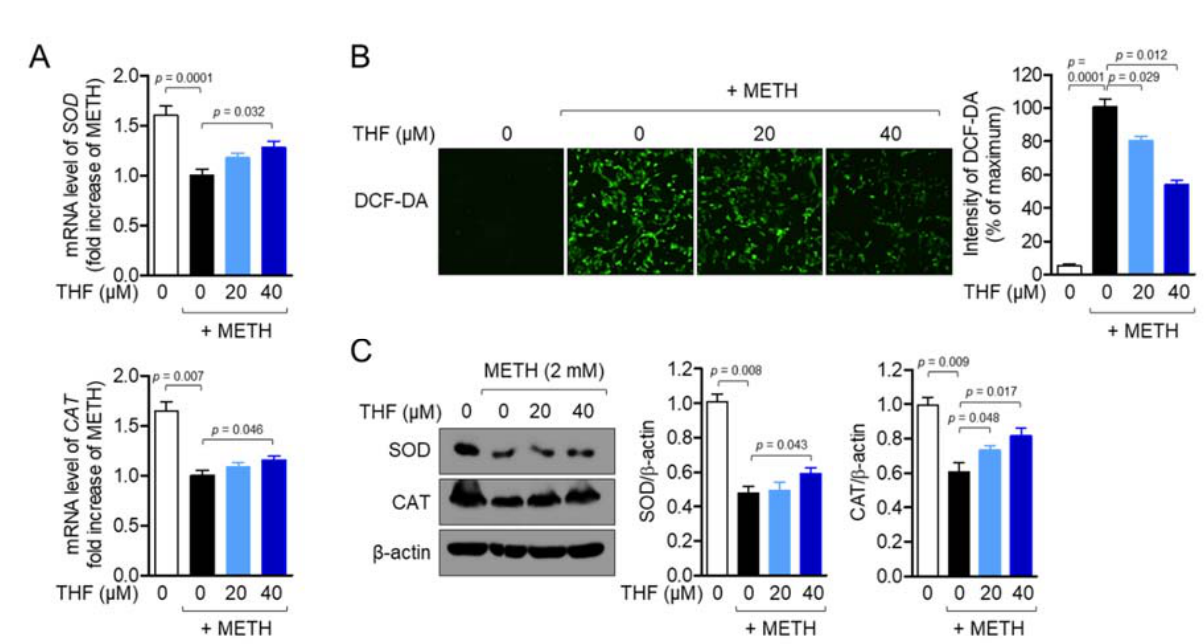
Figure 4. ( A ) SH-SY5y cells were pretreated with the indicated concentration of THF for 6 h and then exposed to 2 mM METH for an additional 6 h. The mRNA levels of superoxidase ( SOD) and catalase ( CAT) genes were determined using real-time PCR analysis. ( B ) SH-SY5y cells (1 × 10 4 /well, 96-well plate) were pretreated with the indicated concentration of THF for 6 h and exposed to 2 mM for an additional 24 h. After incubation, the cells were stained with 2 μ M 2 ′ ,7 ′ -dichlorofluorescin diacetate (DCF-DA) for 20 min. The resulting production of reactive oxygen species (ROS) was detected using the IncuCyte imaging system. The representative images were obtained and the intensity of DCF-DA was calculated as the percentage of the maximum. ( C ) SH-SY5y cells were pretreated with the indicated concentration of THF for 6 h and then exposed to 2 mM METH for an additional 24 h. The expression of SOD and CAT was detected by western blot analysis. The indicated proteins were normalized with the level of β -actin and presented in a bar graph. Results are shown as the mean value of three experiments ± SEM. p value between two indicated groups.